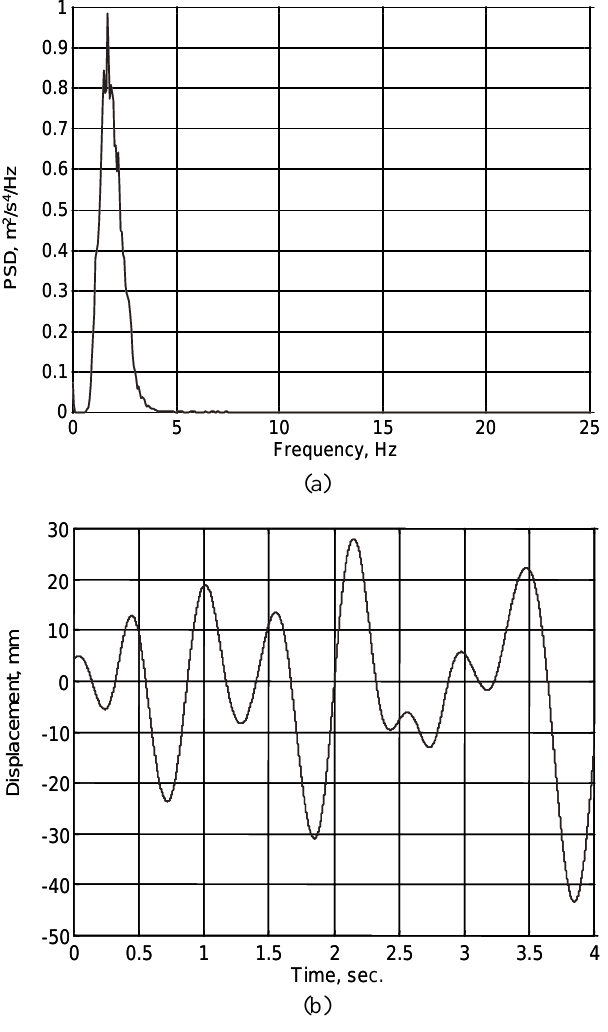
Fig. 4. ISO Class 2 (ISO 2) excitation; (a) Power spectral density; (b) Sample time